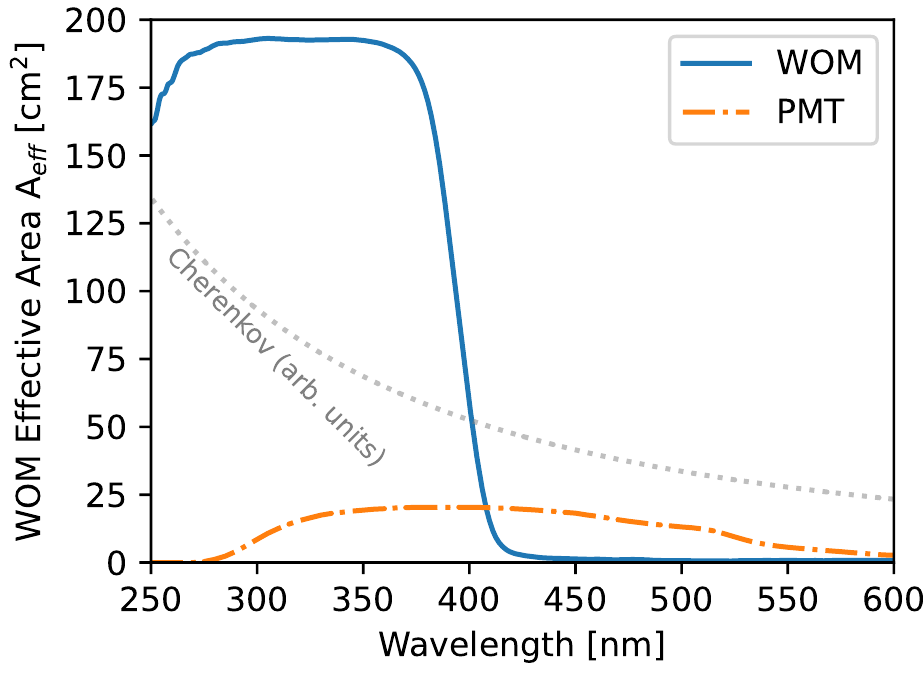
Figure 14. Effective areas of the WOM in the prototype design and a single PMT of this ensemble in dependence on wavelength estimated with the MC simulation described in Section 2.3, assuming both devices are deployed in ice.